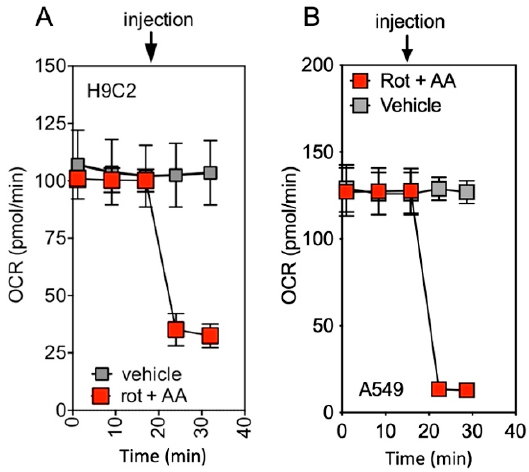
Figure A1. Quantification of OCR (pmol/min/µg protein) in heart ( A ) and lung ( B ) samples. OCR has been assessed from duplicate biopsies of three mice for each condition. Rotenone (Rot) and an- timycin A (AA) were injected at the indicated concentration (see black arrow).